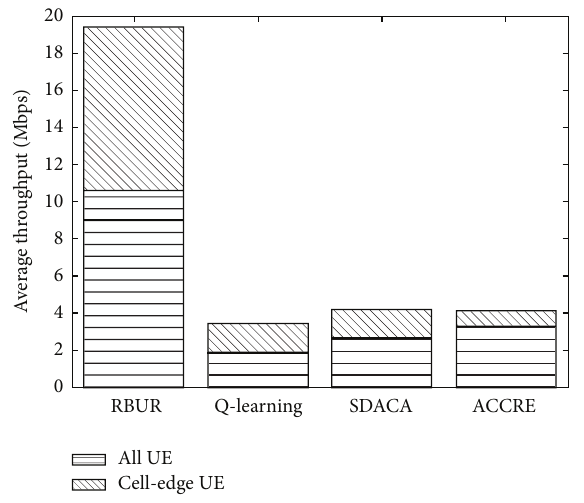
Figure 12: Comparison of average UE